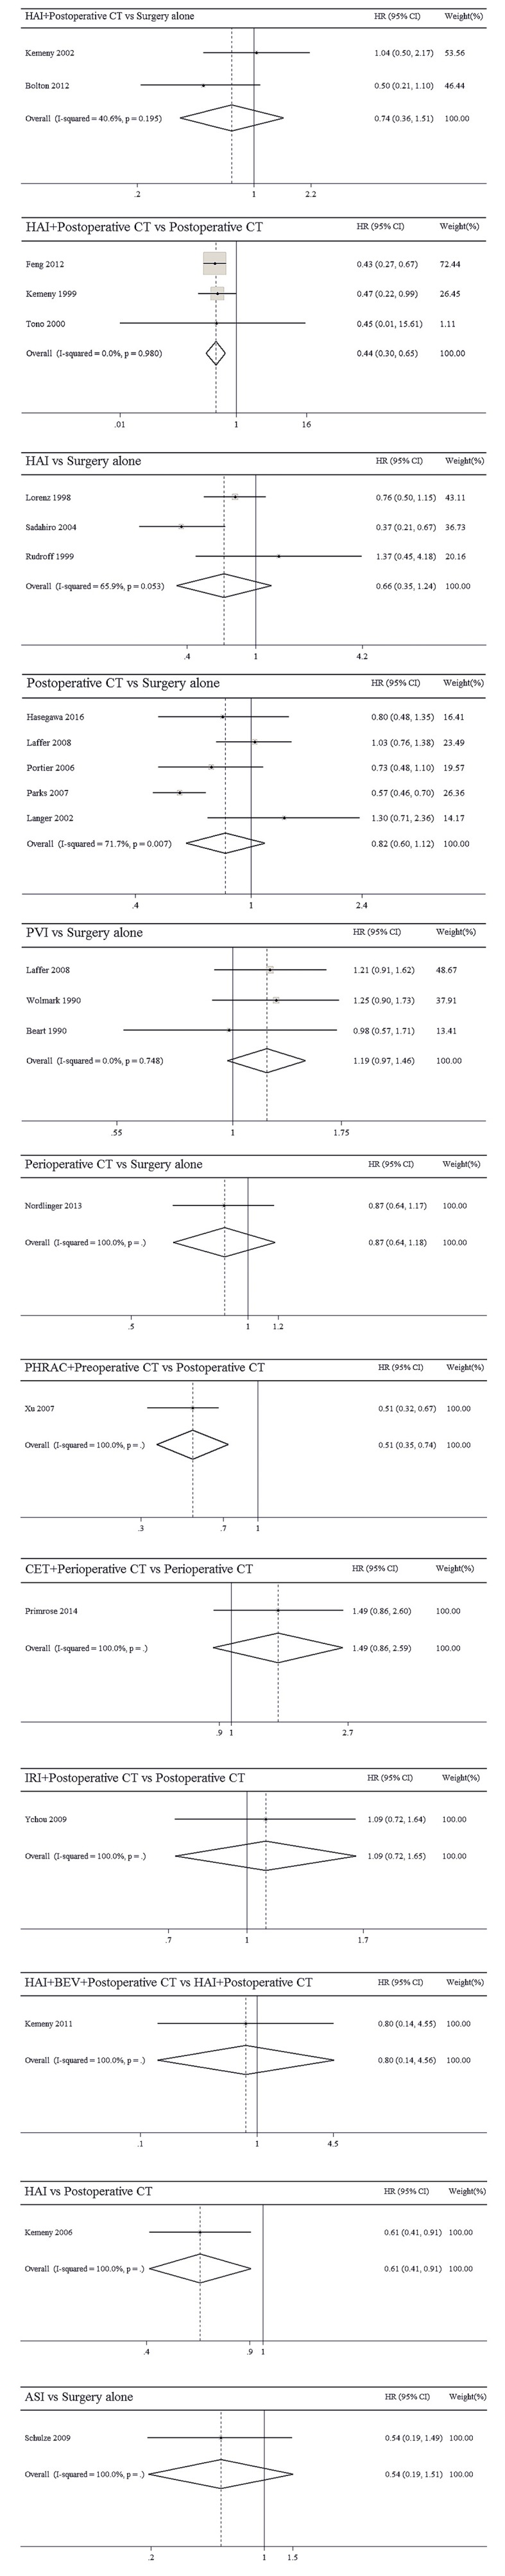
Forest plots of results with pairwise meta-analysis for overall survival.